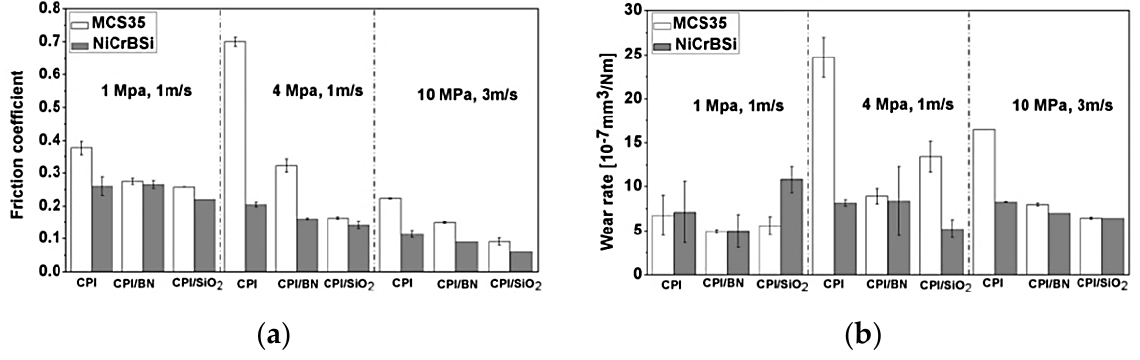
Figure 20. The mean CoF ( a ) and WR ( b ) levels of the PI-based composites upon sliding on the MCS35 and NiCrBSi counterparts. Figure is reproduced with permission from reference [157].